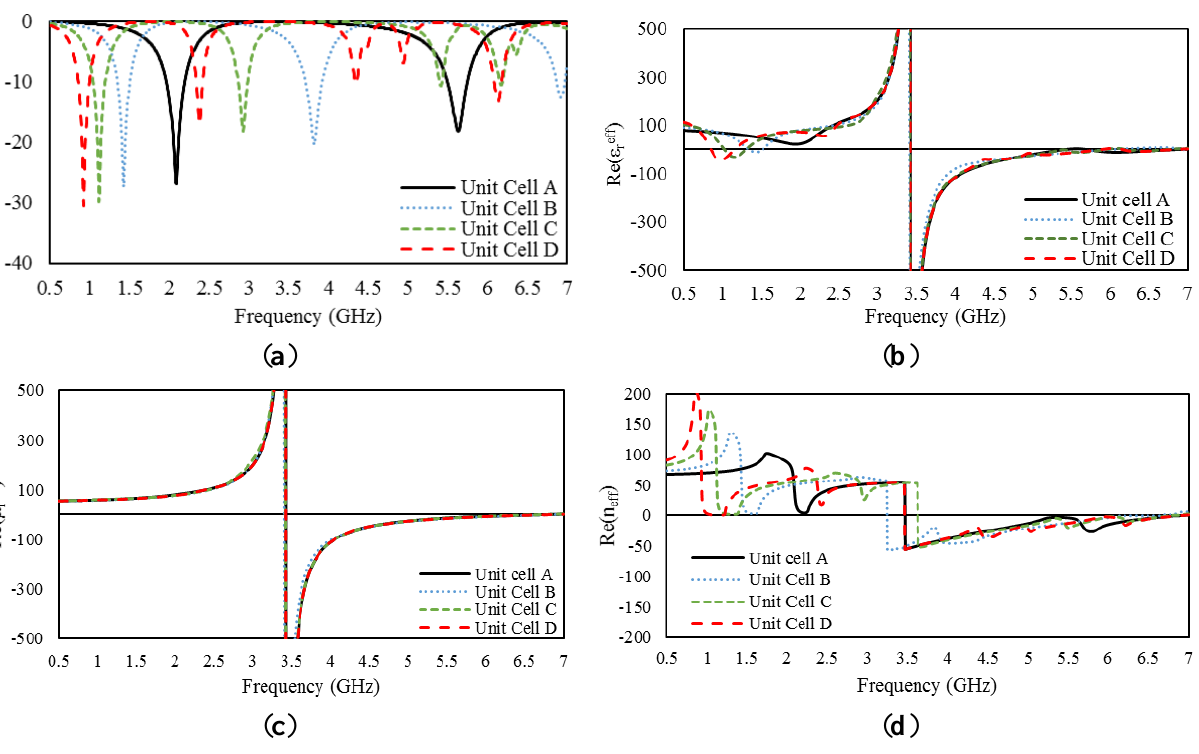
Figure 3. ( a ) S curves for the different unit cells; ( b ) real part of the effective permittivity; 21 ( c ) real part of the effective permeability; and ( d ) real part of the refractive